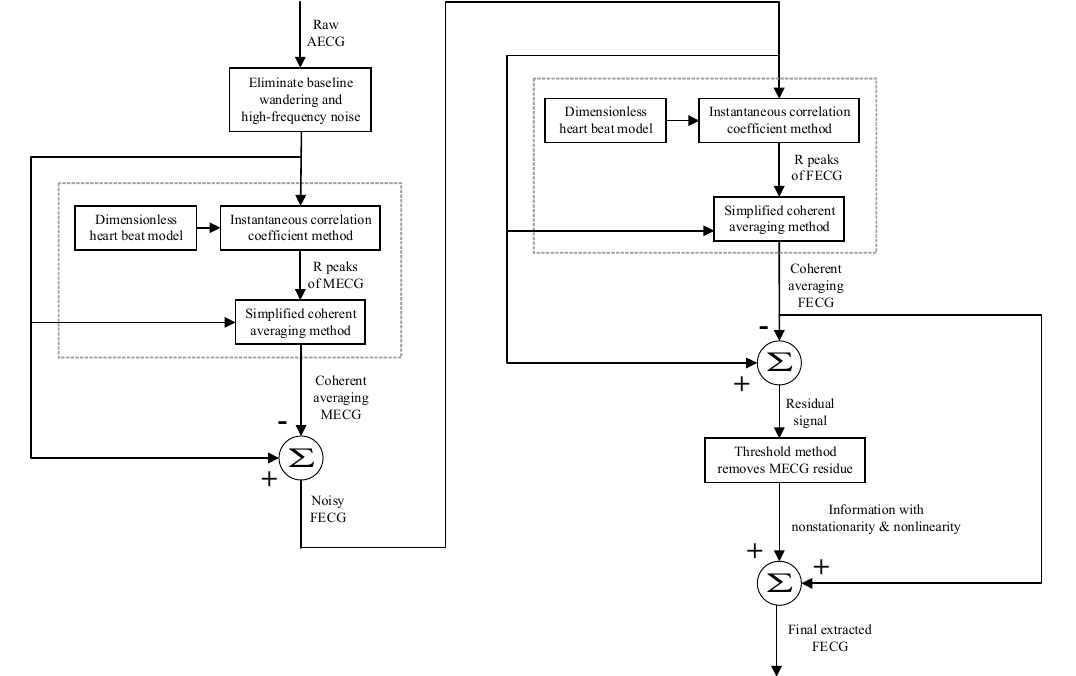
Figure 3. Flow chart of the proposed method. AECG is abdominal ECG and MECG is maternal